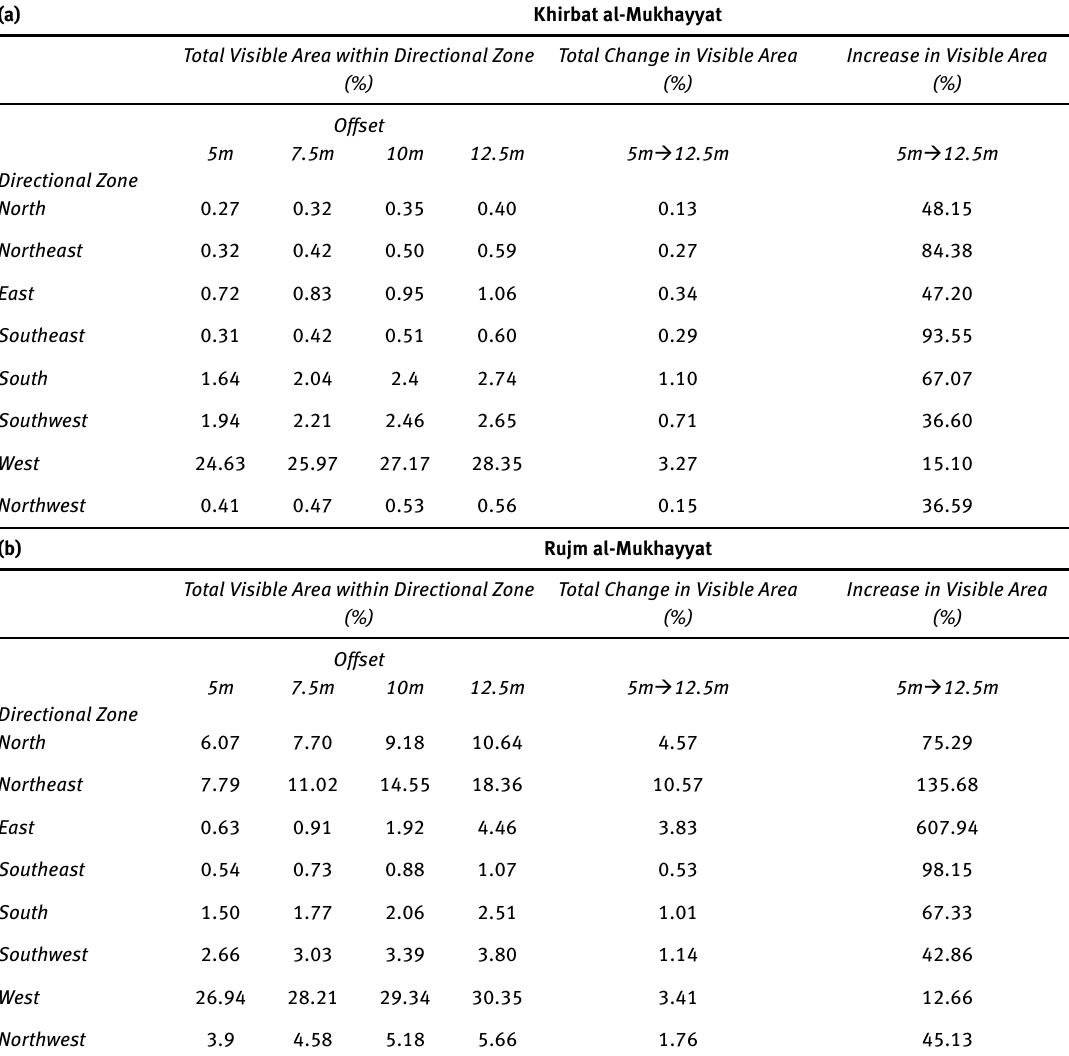
Table 2: Table showing the percentage of total visible area within each directional visibility cone for (a) Khirbat al-Mukhayyat and (b) Rujm al-Mukhayyat. The two columns on the right indicate the total change in visible area and the percentage increase in visible area as measured from the lowest to highest offset elevations (5 m to 12.5